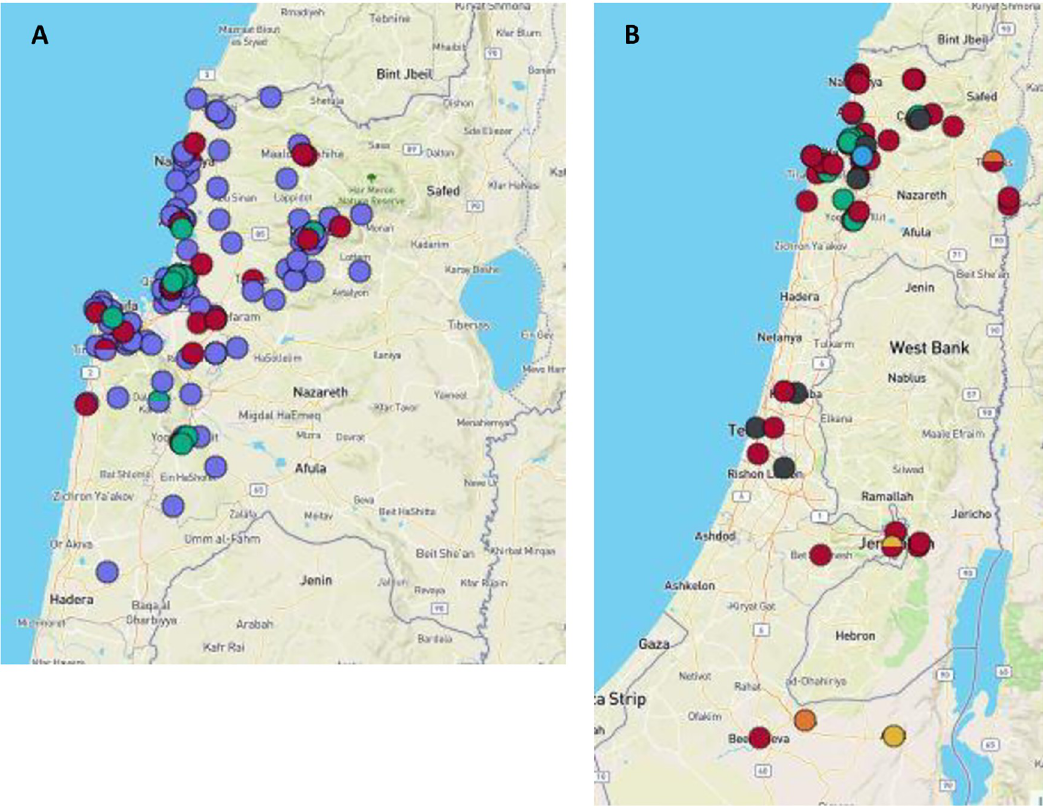
Fig 5. The geographic distribution and genotypes of Cryptosporidium cases in Israel. A. Residence of the 2015 outbreak patients (N = 146), ploted on Haifa and West Galilee geographic map. B. Residence of genotyped patients. Purple, identyfied at the HMO but not genotyped; Red, C . hominis IeA11G3T3 ; Green, C . hominis IbA6G3 . Grey, C . hominis IdA16; Light Blue, C . hominis IbA10G2 ; Yellow, C . parvum IIdA20G ; Orange, C . parvum IIaA15G2R1 . Maps were generated using Microreact [31]; A dynamic version that includes the tested determinants can be found at Microreact https://microreact.org/project/1hgtRJKlg/4da49c44 and https:// microreact.org/project/HD3sxQKDh/350ce02e for Fig 5A and Fig 5B, respectively.